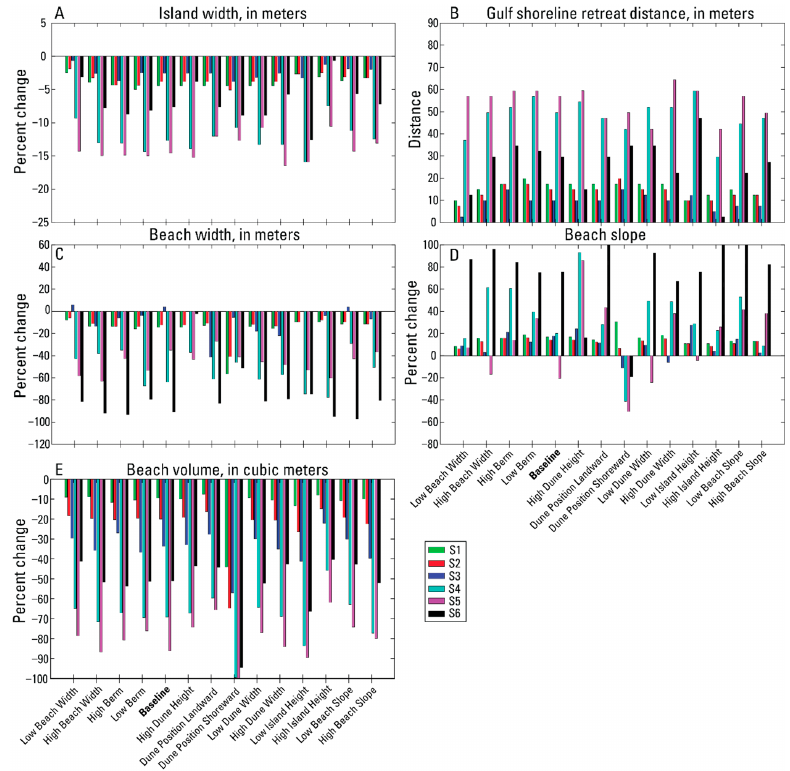
Figure 9. 2D post-storm percent changes to the alongshore averaged (with error bars of standard deviation) maximum island crest elevation ( A ), dune width ( C ), and dune volume ( D ) for storms 1 through 6 (S1–S6). 1D post-storm calculated overwash volume ( B ); note that asterisks indicate the pre-storm dune volume. Metrics are provided in the panel titles to indicate those features that were analyzed, not the values presented in the graphs. Note: y -axis scales differ among panels. J. Mar. Sci. Eng. 2020 , 8 , x FOR PEER REVIEW